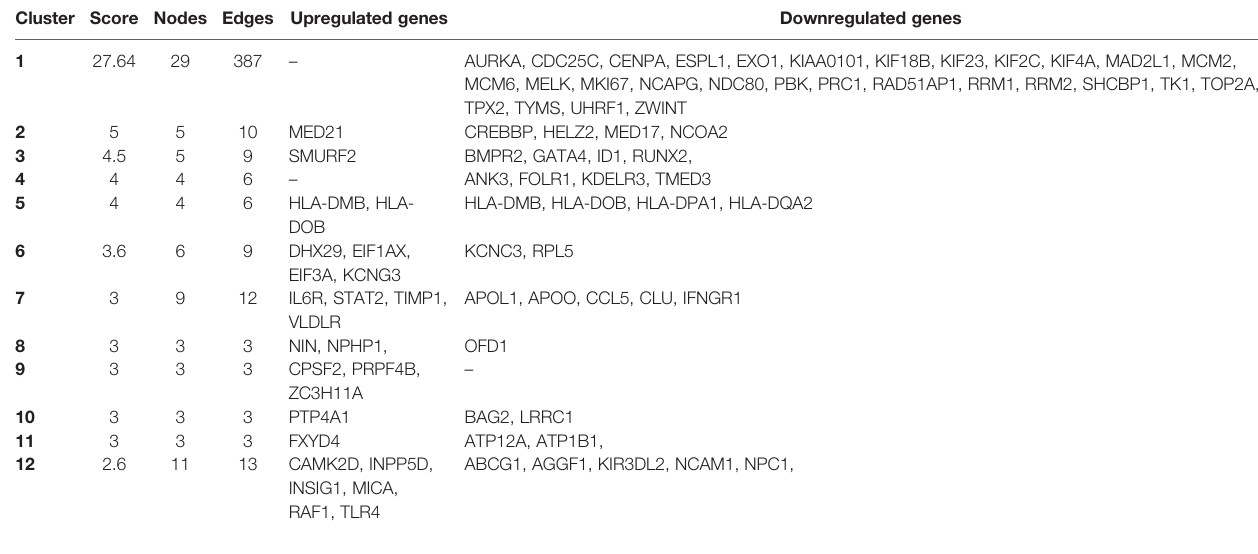
TABLE 2 | Clustering details of DEGs in endometrium of PCOS women during implantation window. Cluster Score Nodes Edges Upregulated